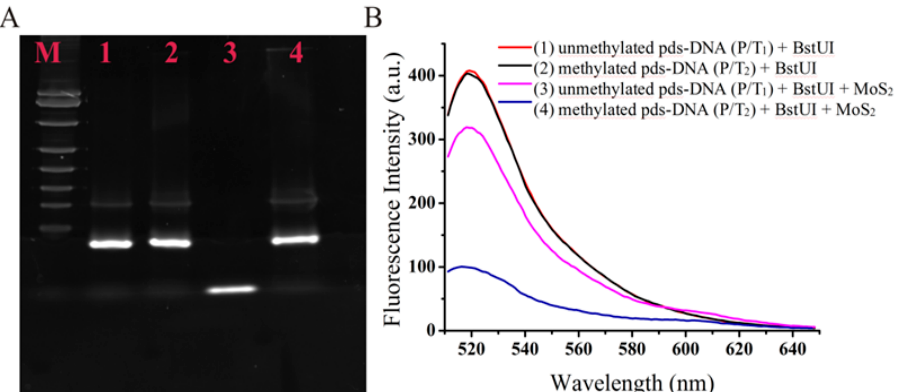
Figure 1. ( A ) Gel image about the methylation-sensitive cleaved process of BstUI in non-denaturing polyacrylamide gel electrophoresis. Lane M: DNA marker; Lane 1: unmethylated pds-DNA (P/T 1 ); Lane 2: methylated pds-DNA (P/T 2 ); Lane 3: unmethylated pds-DNA (P/T 1 ) + BstUI; Lane 4: methylated pds-DNA (P/T 2 ) + BstUI. ( B ) Fluorescence emission spectra of the DNA detection and methylation analysis strategy under different conditions: (1) unmethylated pds-DNA (P/T 1 ); (2) methylated pds-DNA (P/T 2 ); (3) unmethylated pds-DNA (P/T 1 ) + BstUI + MoS 2 ; (4) methylated pds-DNA (P/T 2 ) + BstUI + MoS 2 .